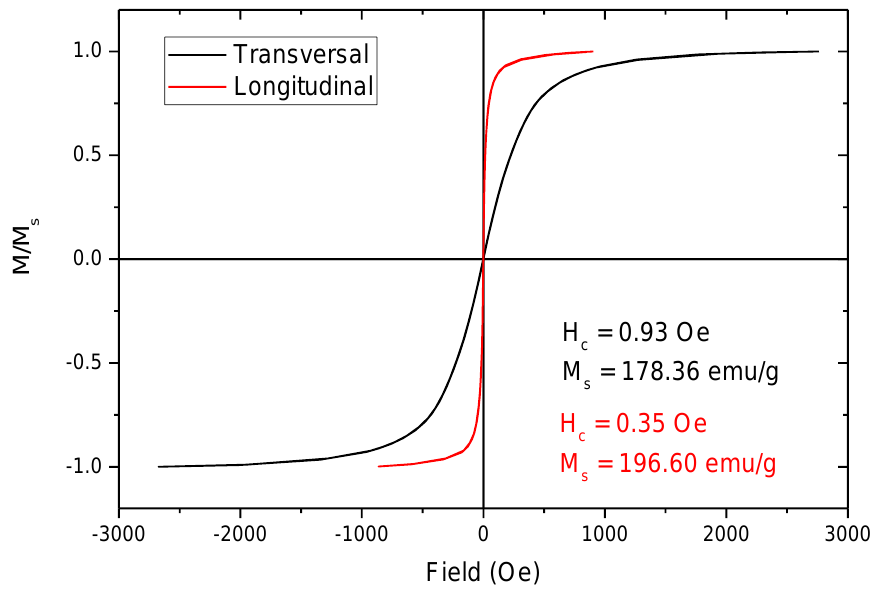
Figure 2. Normalised hysteresis loops of the Fe 77.5 Si 7.5 B 15 at.% uncoated fibres magnetised in a longitudinal and transversal direction.